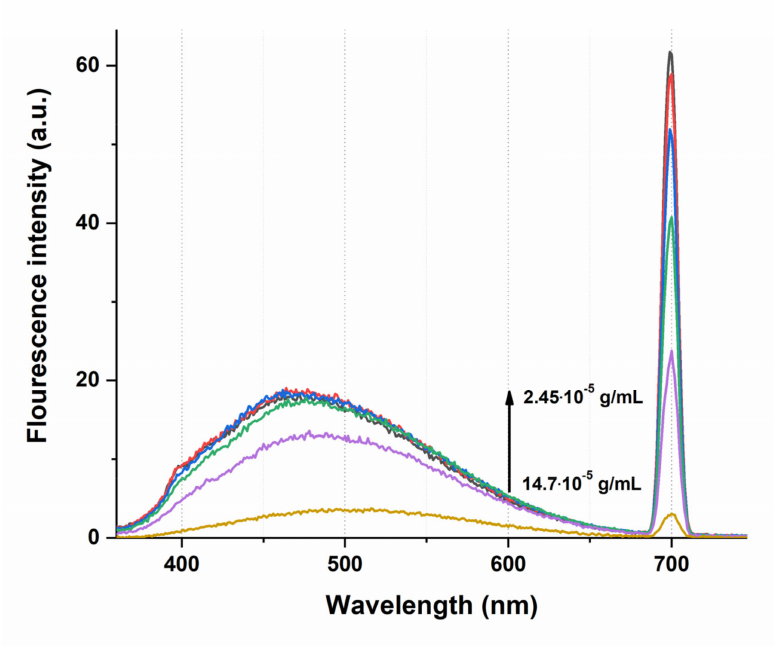
Figure 3. Fluorescence spectrum of HC aqueous dilutions in the concentration range from 14.7 × 10 − 5 to 2.45 × 10 − 5 g/mL (1:500–1:3000), λ ex = 350